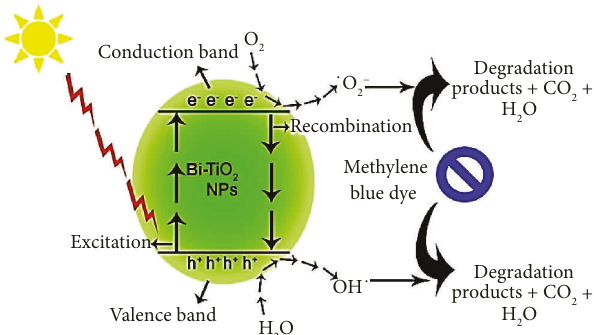
Figure 6: Schematic representation of MB dye degradation